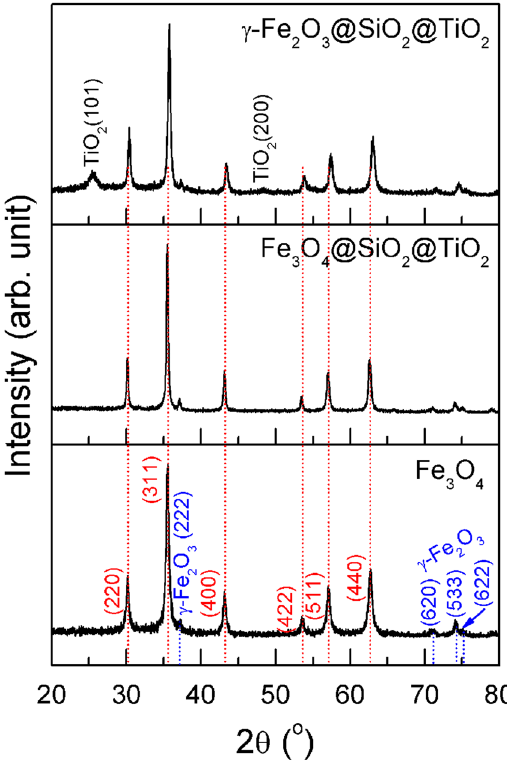
Figure 1. XRD patterns of Fe 3 O 4 , Fe 3 O 4 @SiO 2 @TiO 2 , and γ -Fe 2 O 3 @SiO 2 @TiO 2